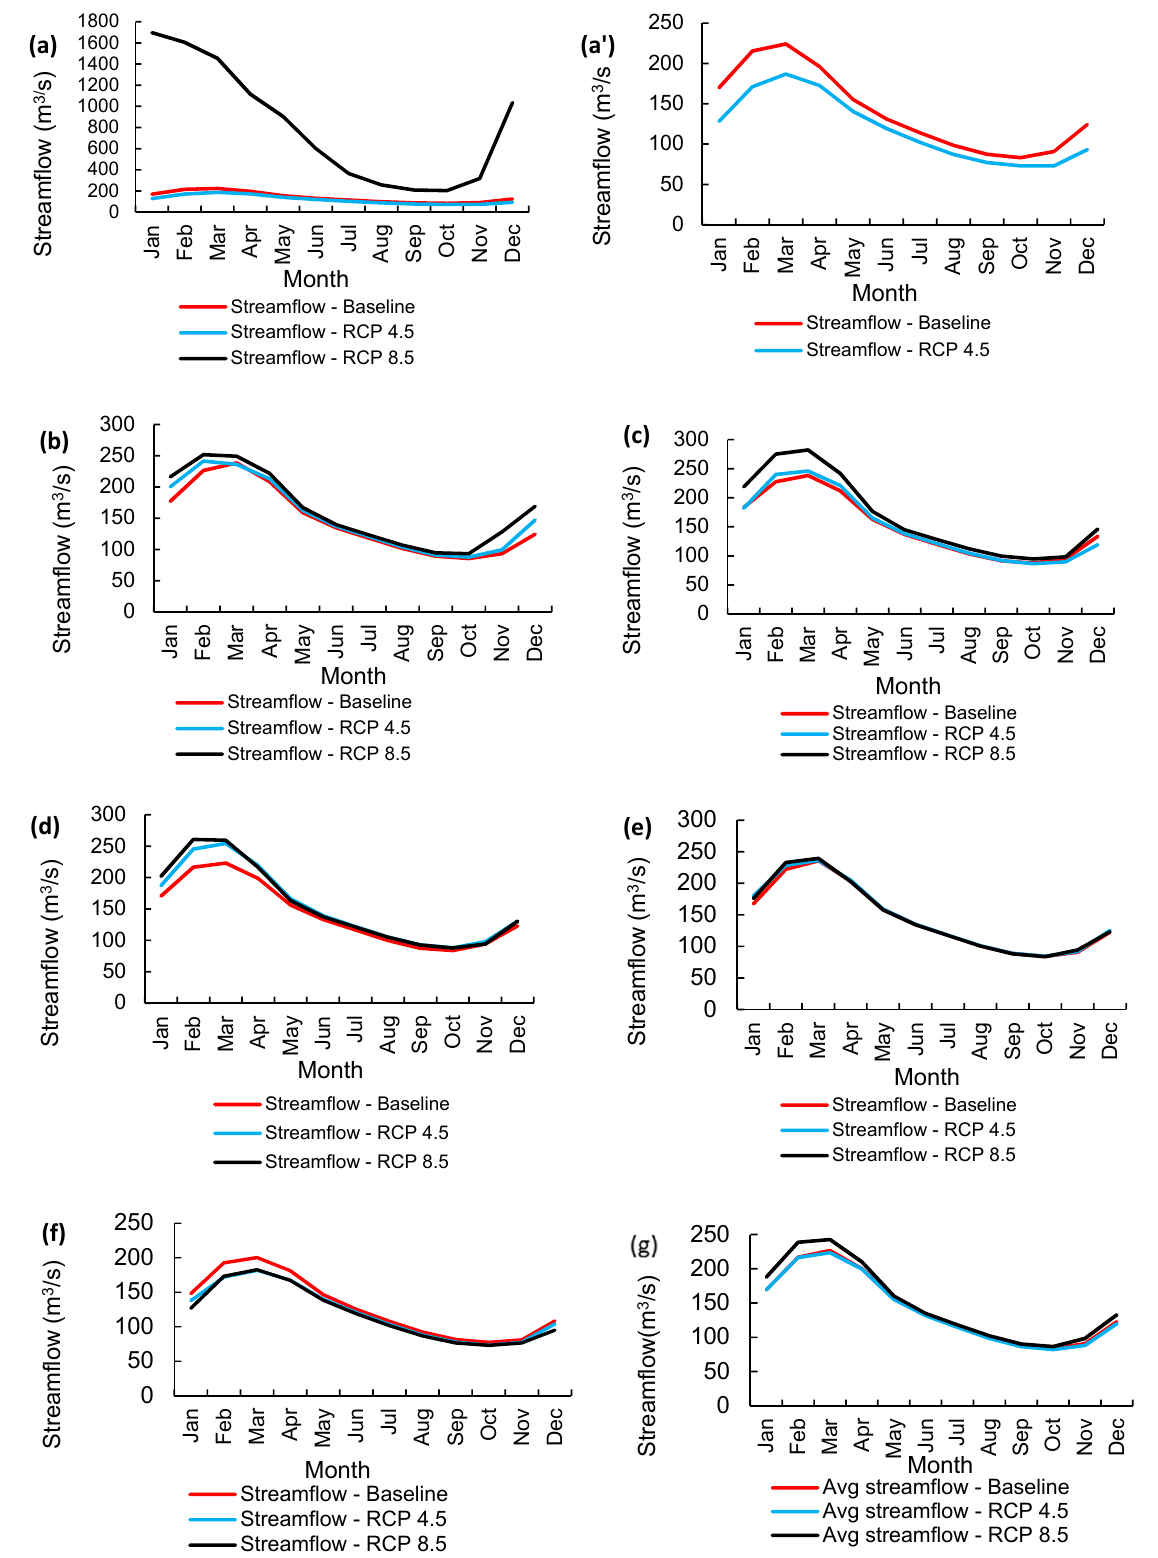
Figure 4. Streamflow simulations based on individual global climate models: ( a ) ACCESS1-0 (high uncertainty); ( a ′ ) AC- CESS1-0 (strong consensus); ( b ) CNRM-CM; ( c ) IPSL-CM5A-LR; ( d ) MIROC; ( e ) MPI-ESM-MR; ( f ) MRI-CGCM3-MR; and ( g ) average streamflow for GCM Ensemble.